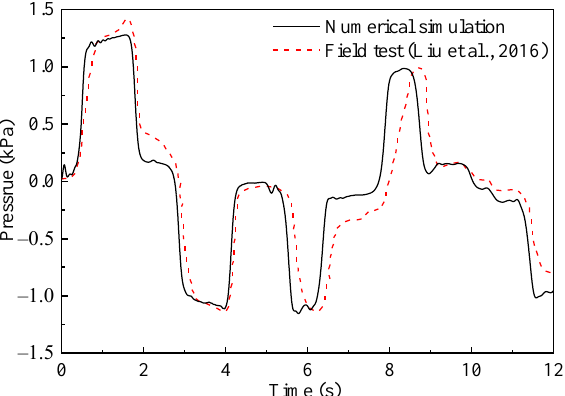
Figure 9. Aerodynamic pressures obtained by numerical simulation and field test.